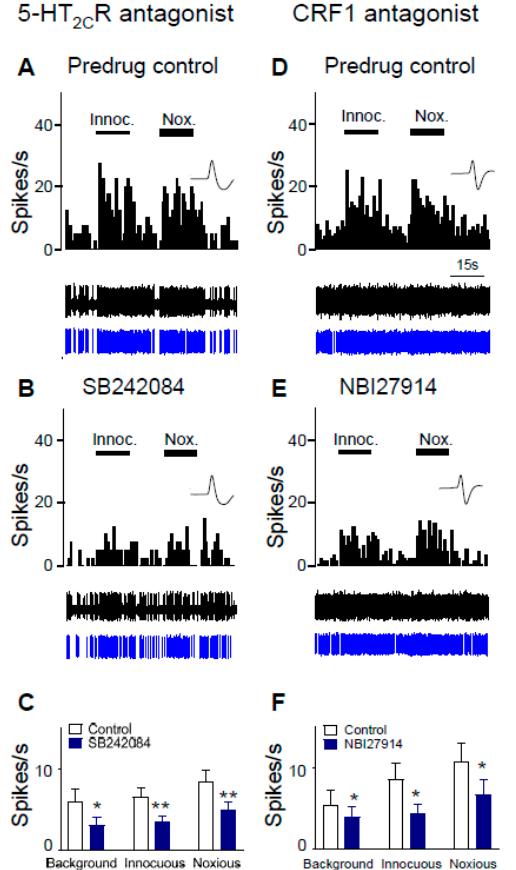
Figure 3. Inhibitory effects of antagonists for 5-HT 2C R (SB242084) and corticotropin-releasing factor 1 (CRF1) receptor (NBI27914) on CeA neurons in a neuropathic pain model. CeA neurons were recorded in SNL rats 2 weeks after control shRNA was injected into the BLA, i.e., 4 weeks post SNL surgery. Background activity and evoked responses to innocuous and noxious stimulation of the left hindpaw are shown. ( A , B ) SB242084 administered into BLA (100 µM concentration in microdialysis fiber; 15 min; ( B )) decreased background and evoked responses compared to predrug control (ACSF; ( A )) in an individual CeA neuron. Top traces, peristimulus time histograms (PSTHs) showing the number of action potentials (spikes) per second. Middle traces, original oscilloscope traces. Bottom traces, filtered spikes matched to a preset template that were counted to generate PSTH values. ( C ) Summary of the significant inhibitory effects, SB242084 effects ( n = 8 neurons). *, ** p < 0.05, 0.01, paired t -test compared to predrug control (ACSF), respectively. ( D , E ) NBI27914 (100 µM concentration in microdialysis fiber; 15 min; ( E )) decreased background and evoked responses compared to predrug control (ACSF; ( D )). Same display as in ( A , B ). ( F ) Summary of the significant effects of NBI2791 ( n = 5 neurons). * p < 0.05, paired t -test compared to predrug control (ACSF).